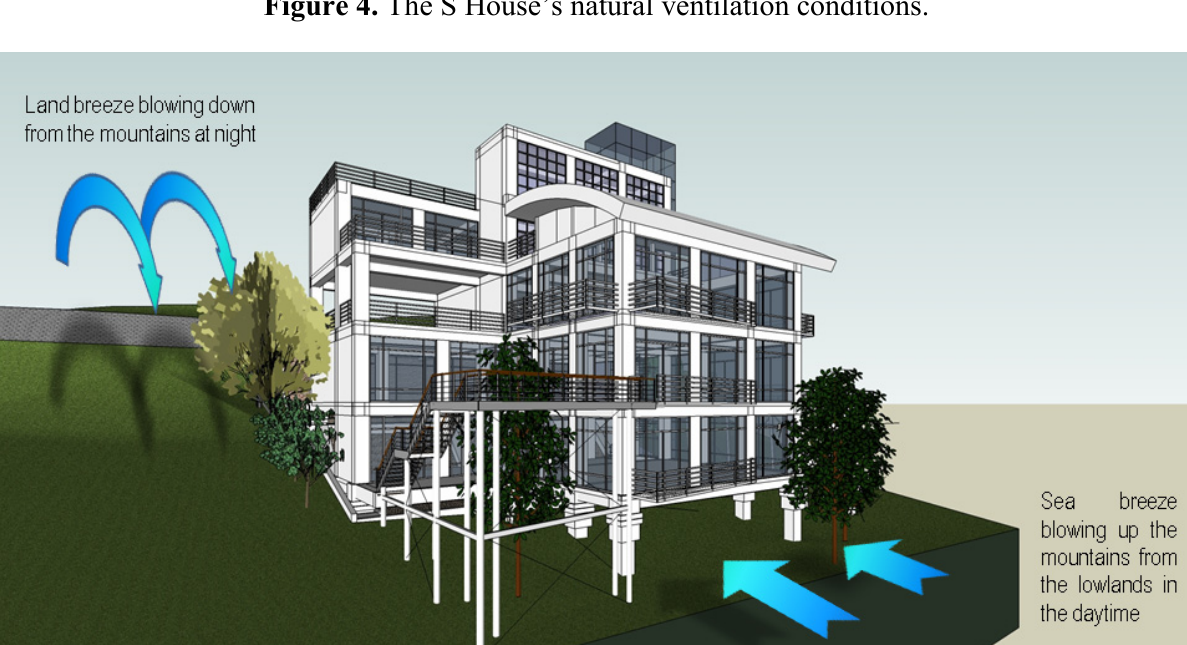
Figure 4. The S House’s natural ventilation